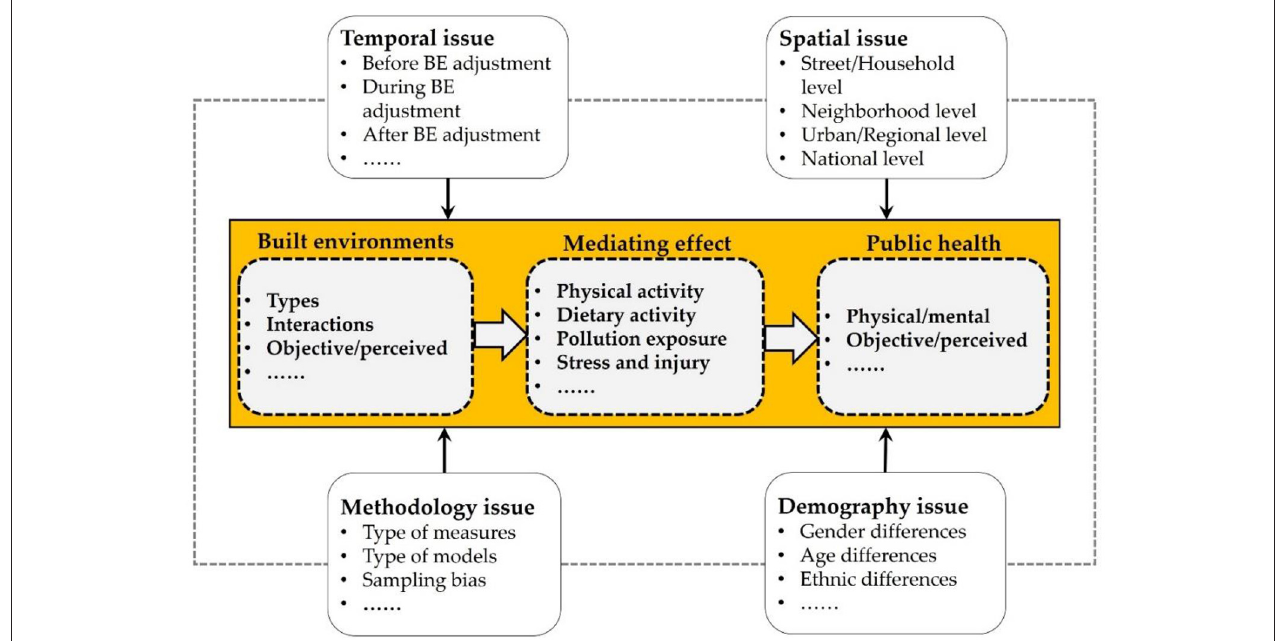
FIGURE 5 | Significant issues that impact the built environment—health